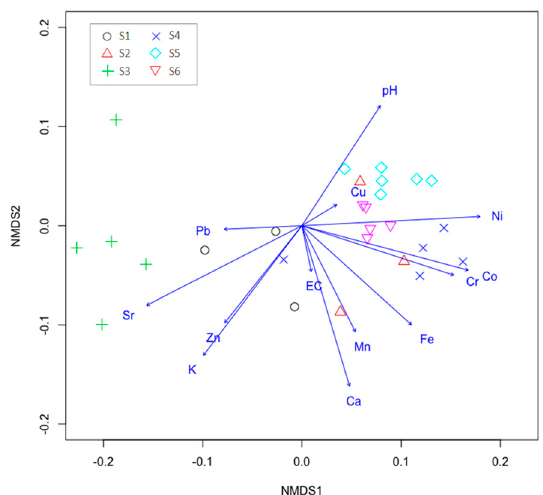
Figure 4. Non-metric multidimensional scaling (NMDS) ordination diagrams for the relationship between trace elements and studied sub-units. Lines show trace element trends; figures represent sub-units S1 to S6.